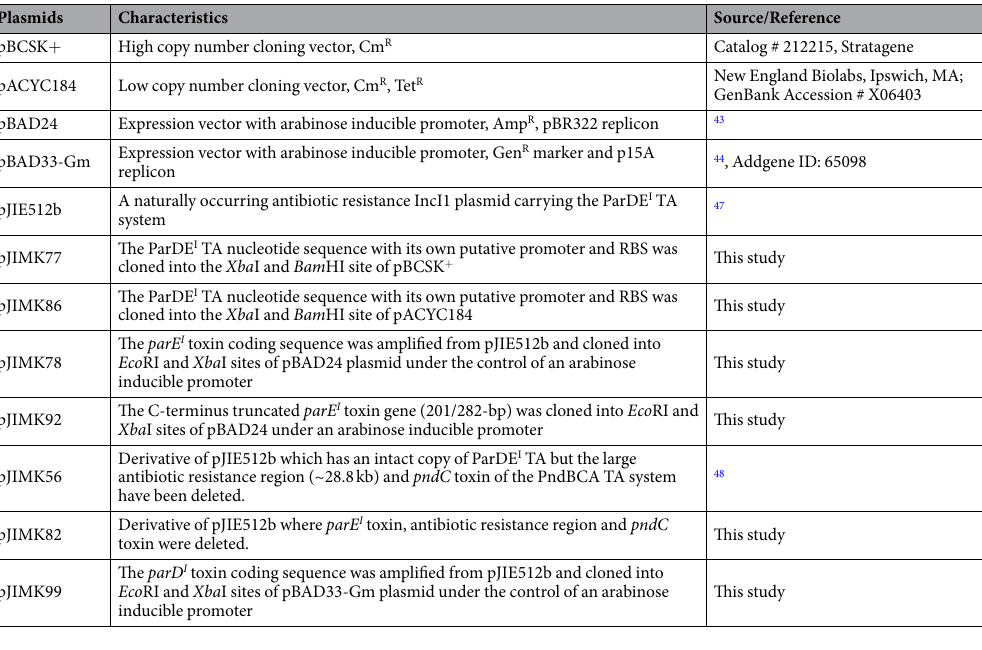
Table 1. Plasmids used in this